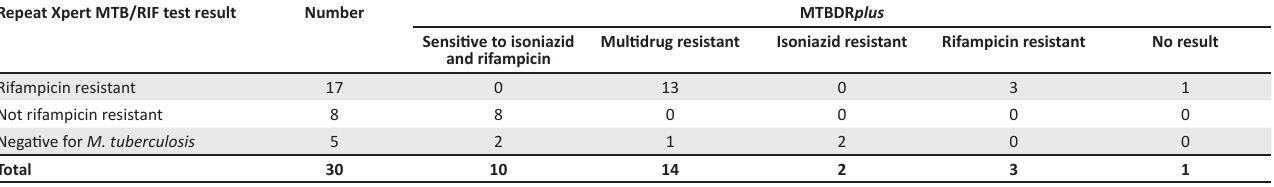
TABLE 2: Comparison of repeat Xpert MTB/RIF and MTBDR plus test results.